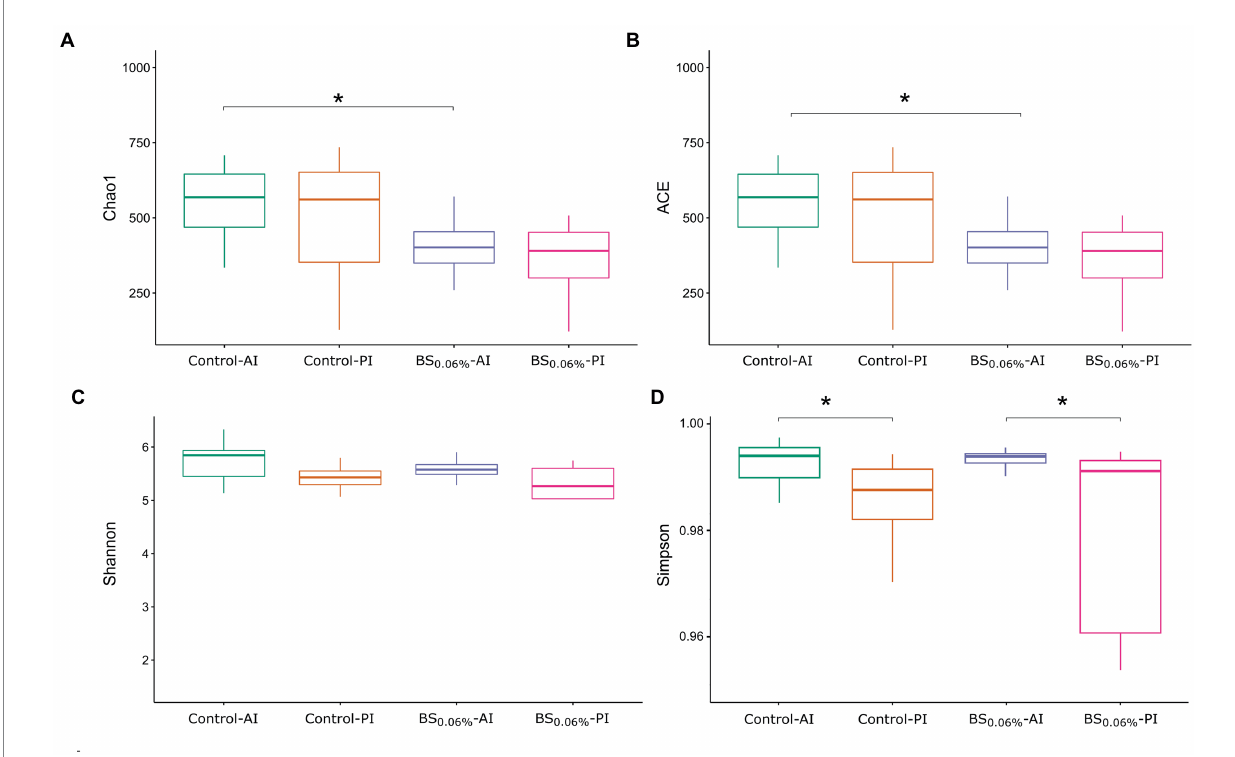
FIGURE 1 Box plots representing the minimum, maximum and the median of the sample values obtained from the richness estimators Chao1 (A) and ACE (B) , and diversity indices Shannon (C) and Simpson (D) . The asterisks represent the significant differences between dietary condition or intestinal region of gilthead seabream ( Sparus aurata ; Kruskal—Wallis, Dunn’s post-test, P < 0.05). Experimental groups ( n = 12 fish per group): anterior (Control-AI) and posterior intestine (Control-PI) of S. aurata fed the control diet, and anterior (BS 0.06% -AI) and posterior intestine (BS 0.06% -PI) of S. aurata fed the BS 0.06% diet.